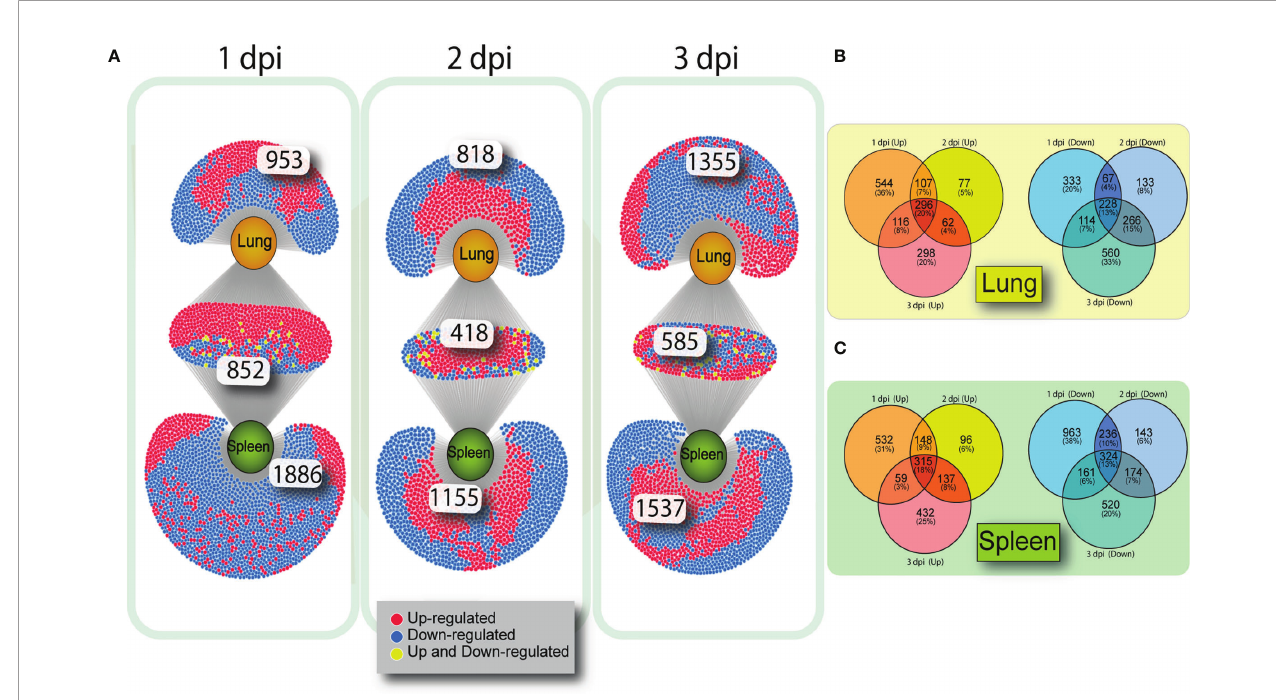
FIGURE 2 | Venn diagrams showing overlap of gene expression on 1, 2 and 3 dpi in VN1203 infected ducks. Differentially expressed genes were assigned up or down regulated based on log2(FC) (upregulated>1, downregulated<-1) and overlap of DEGs was compared between tissues using DiVenn (A) . Overlap of up or downregulated gene populations speci fi c to each tissue in ducks infected with VN1203 in lung (B) or spleen (C) created using Venny